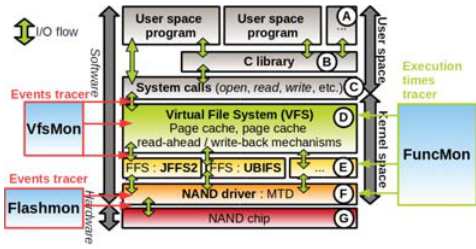
Figure 1: FFS storage management with